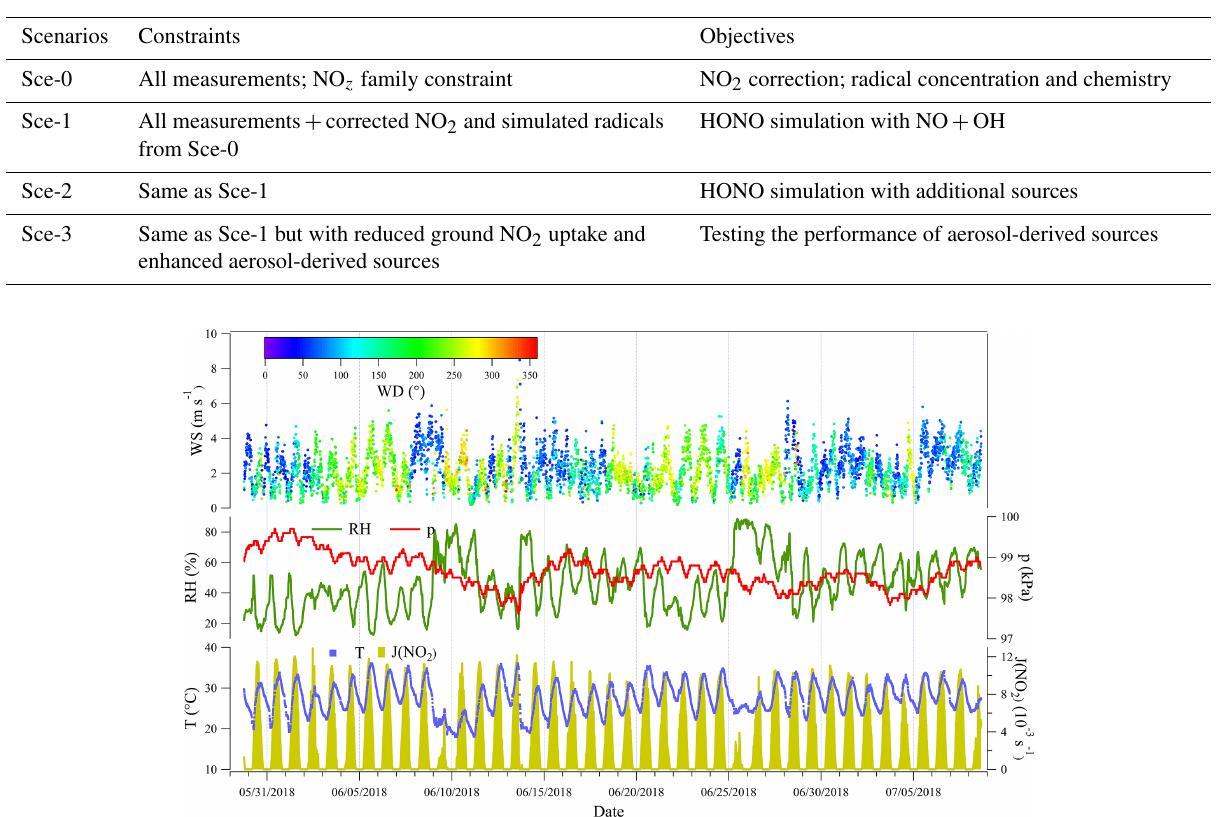
Table 1. Description of different model scenarios.